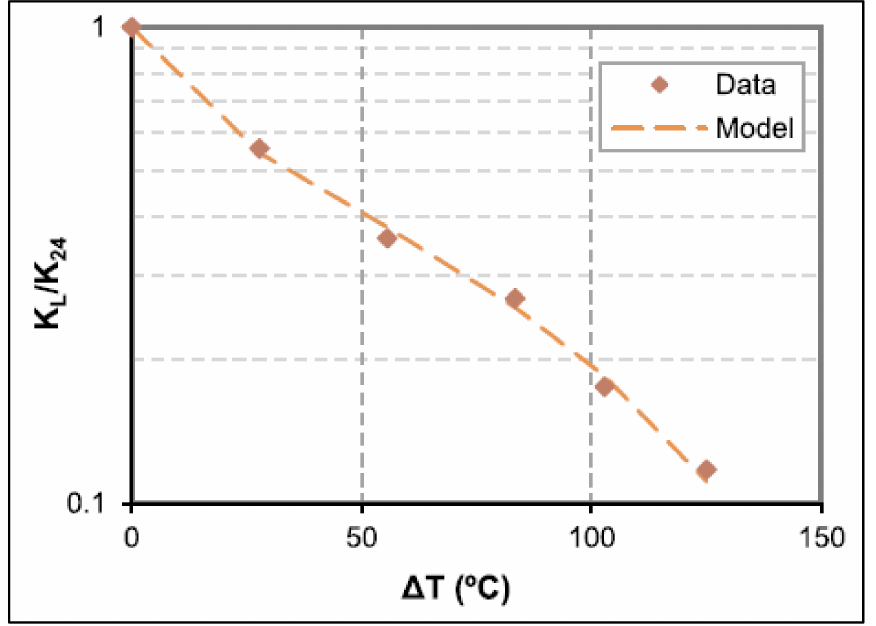
Figure 11. Fluid consistency index against temperature. (Reprinted with the permission from Sinha et al. [51]). Copyright 2019, Elsevier